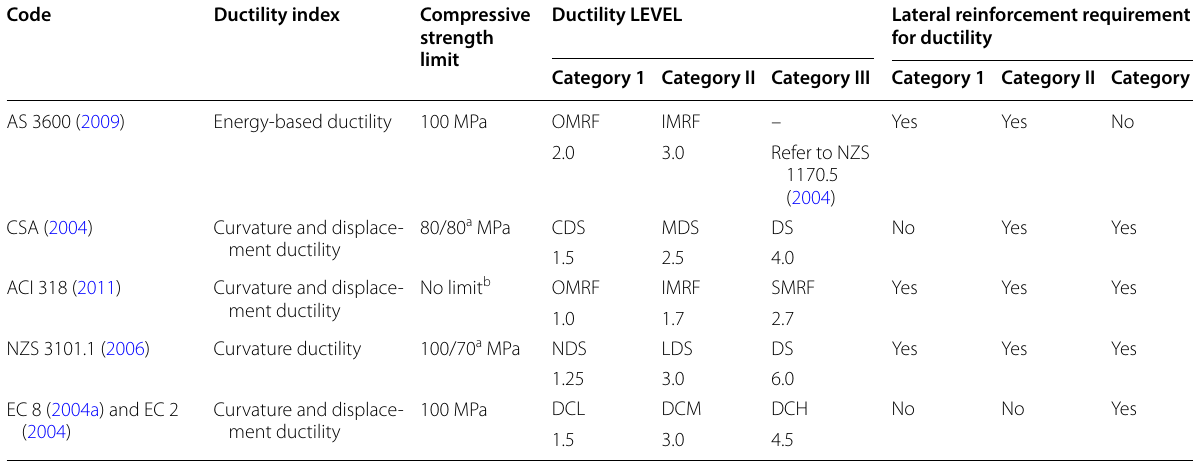
a For ductile elements in seismic design. b Concrete strength limited in some design equations.